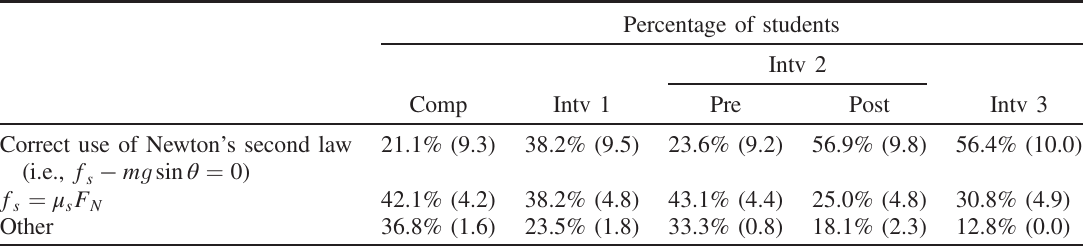
TABLE V. Percentage of students in each group who used particular problem-solving approaches in the calculus- based course. The average score obtained by students in each group is also listed in the parentheses for reference.